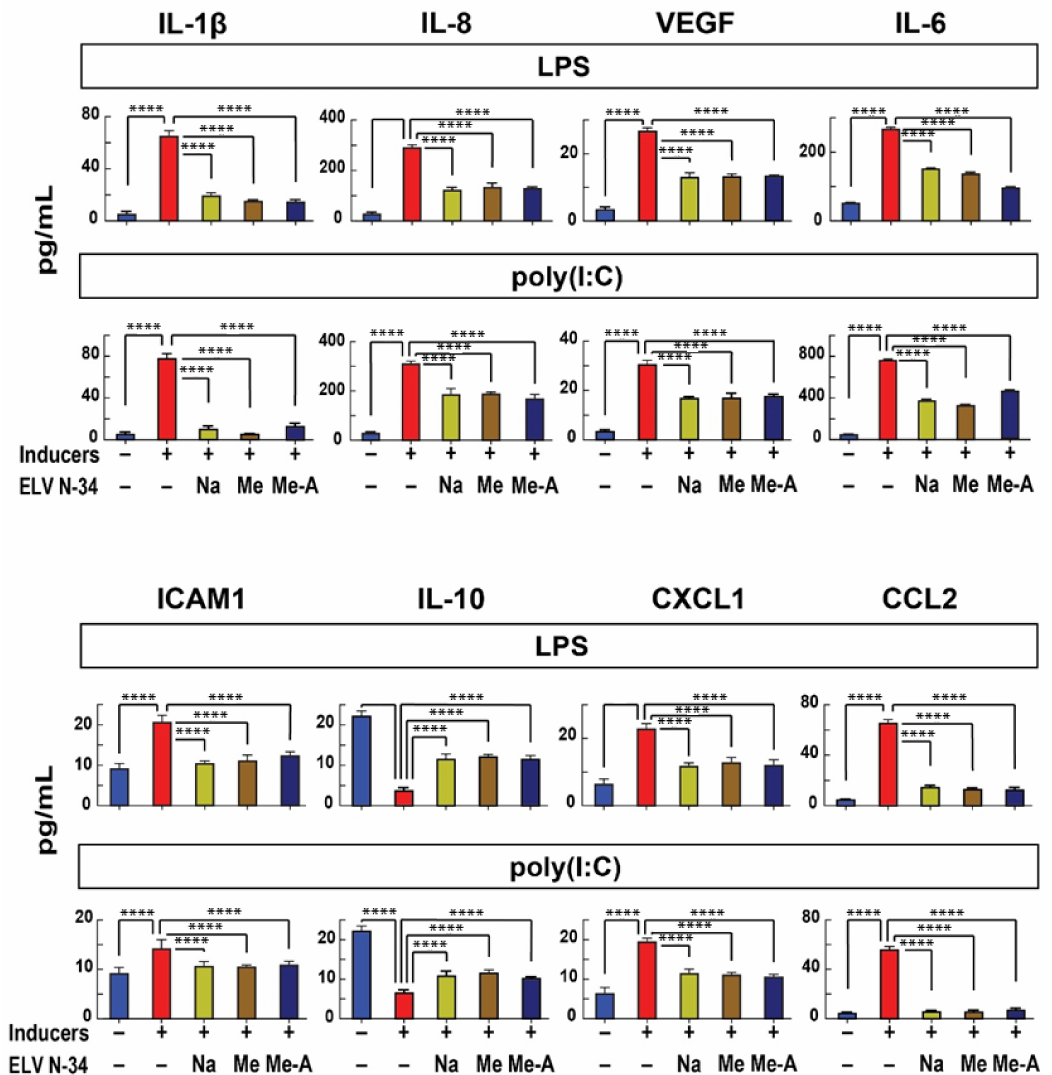
Figure 3. ELVN-34 reduce the expression of pro-inflammatory cytokines, chemokines and cell adhesion molecule in HNEpC challenged with LPS or poly(I:C). HNEpC challenged with LPS or poly(I:C) (30 µ g/mL) display enhanced production of pro-inflammatory cytokines and chemokines IL-6, IL-1 β , IL-8/CXCL8, CCL2/MCP-1, CXCL1/KC/GRO, VEGF, and cell adhesion molecule ICAM1(CD54) compared to non-treated cells. This increase in the production of pro-inflammatory molecules is abrogated by the addition of ELVN-34 (500 nM) 30 min post-challenge. LPS and poly(I:C) induce a reduction of anti-inflammatory IL-10 expression in HNEpC that is restored to normal levels after treatment with ELVN-34 (500 nM). The results showed the averages of three independent experiments. (**** p <